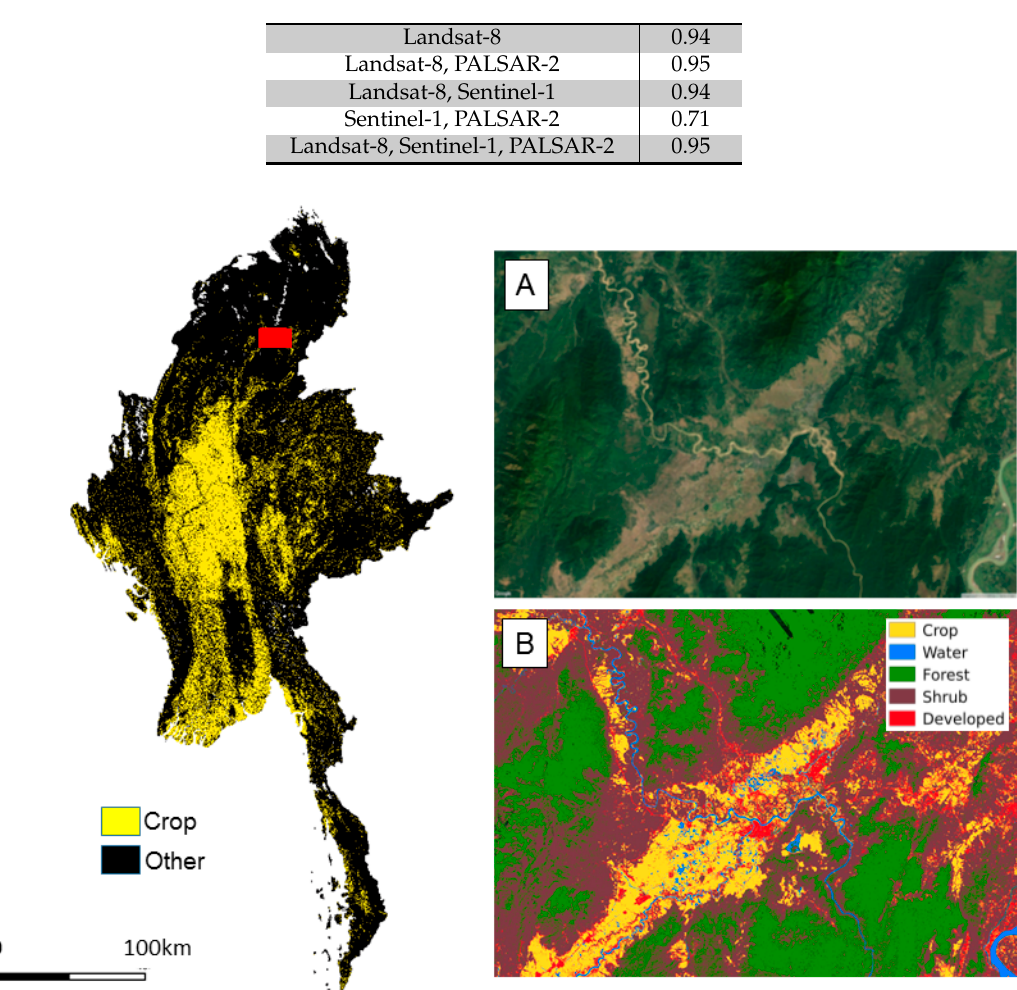
Figure 10. Updated (2015) crop mask for Myanmar using integrated optical and SAR inputs and example zoomed in snapshot ( A : Google Earth, B : Classification) of Mogaung region within Kachin State.